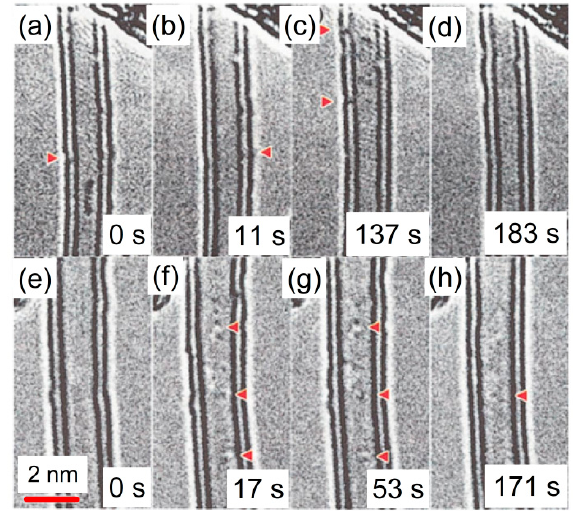
Figure 33. Sequential HRTEM images of the interlayer defects which appear and disappear in DWCNTs recorded at 573 K. In the side wall ( a – d ), several bridges connecting two graphene layers frequently appear in dark contrast (marked by red arrows) and disappear just after the observation. Also, in the top wall ( e – h ), pairs of dark and bright contrast often appear and then vanish (marked by red arrows). Reproduced with permission from Urita et al. [116]. Copyright American Physical Society, 2005.